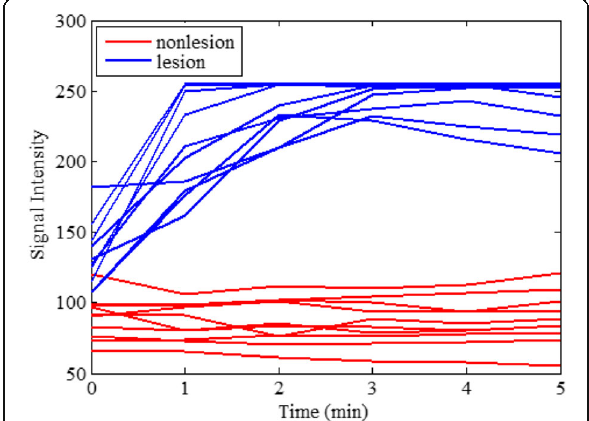
Fig. 4 Comparison of signal intensity variation over time in lesion and non-lesion tissues. Blue and red curves present signal intensity variation over time (one pre-contrast and five post-contrast time points) for twenty voxels which belong to different lesion and non-lesion tissues,